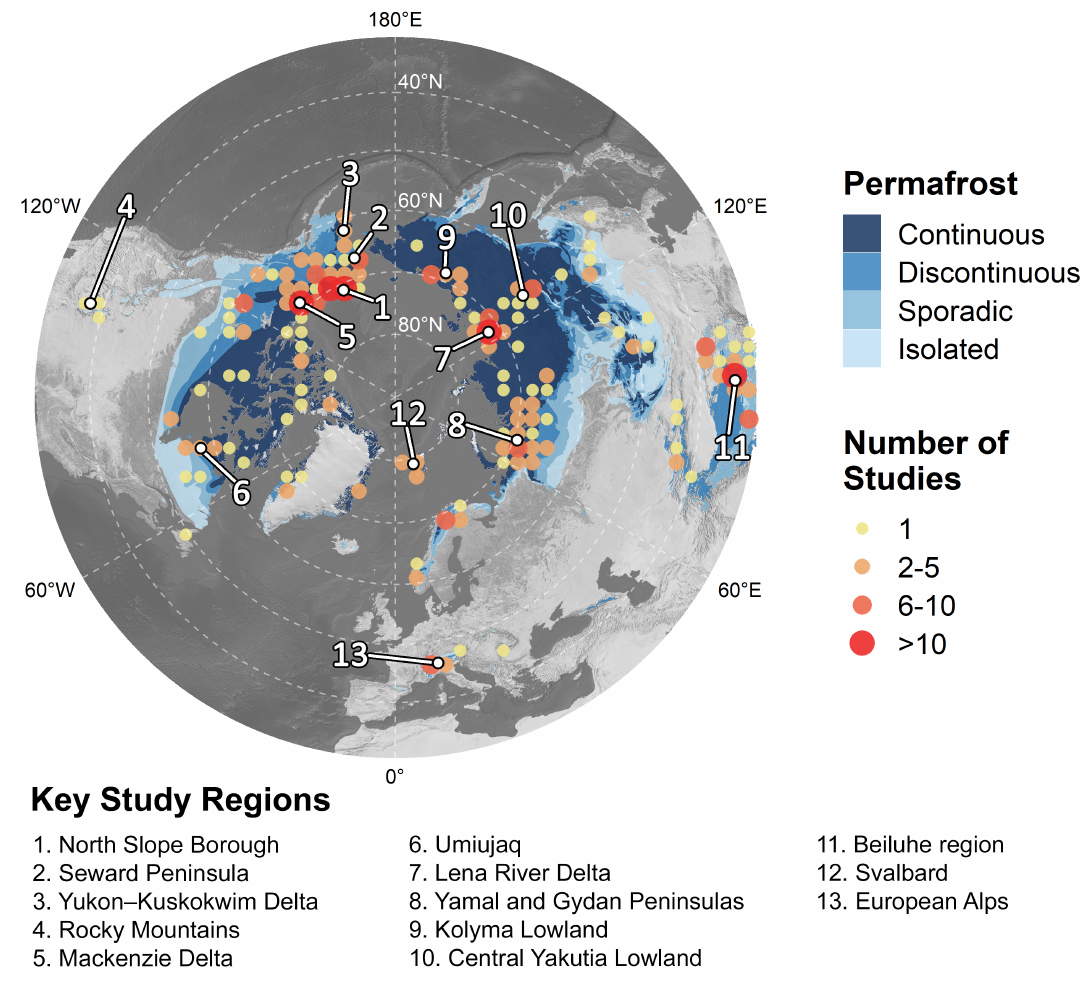
Figure 5. The study area distribution of the reviewed articles for the Northern Hemisphere together with the circum-Arctic permafrost map by Brown et al. [1] (bluish coloured areas). One study may have several study areas. A shaded relief by Natural Earth [203] was utilized as a background map. All data is visualized in a polar Lambert azimuthal equal area projection. Circum-Arctic studies were excluded from this visualization. Thirteen key regions with study clusters are marked and